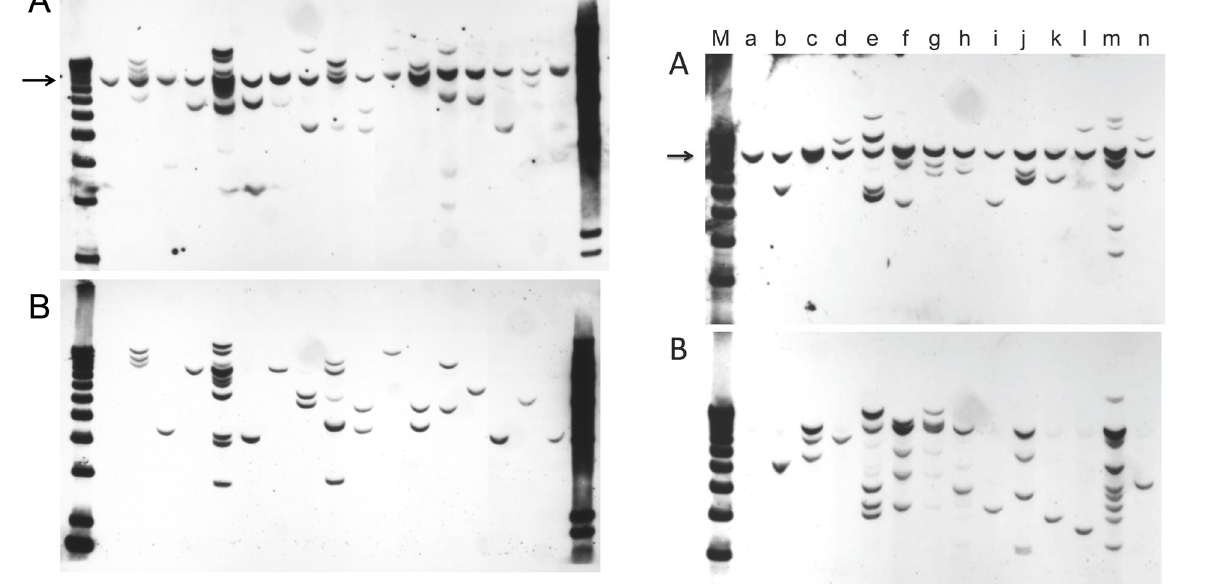
Figure 6. Integration patterns of the myc and ras genes in cell lines derived from tumors induced by linear pMSV-T24-H- ras / MSV-c- myc . DNA was isolated from tumor cell lines, digested with Bgl II, an enzyme that cuts the plasmid once, transferred to a membrane, and probed first with a myc probe ( A ), and then (after stripping the membrane) with a ras probe ( B ). Lane a is mouse NIH 3T3 DNA; lanes b to n represent different tumor cell lines. The position of the endogenous mouse c- myc gene is indicated by the